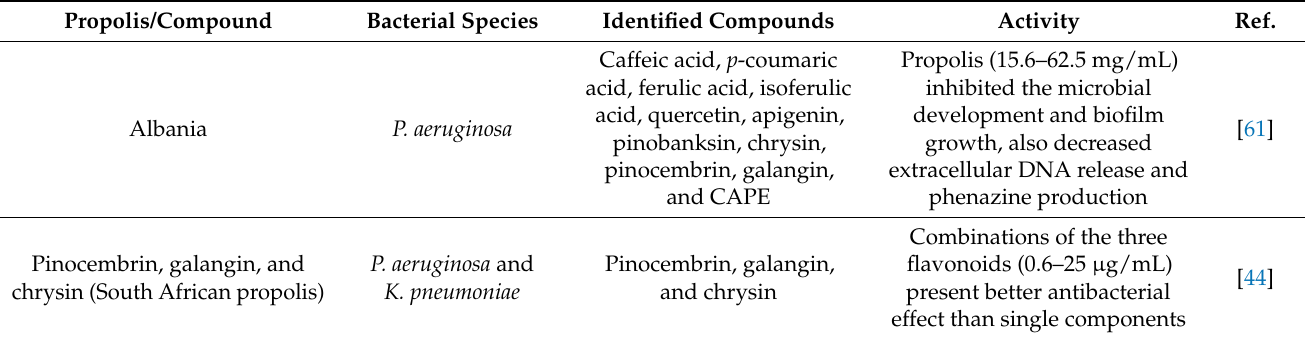
Table 7. Effect of diverse propolis and its main identified components on P. aeruginosa and K. pneumoniae .